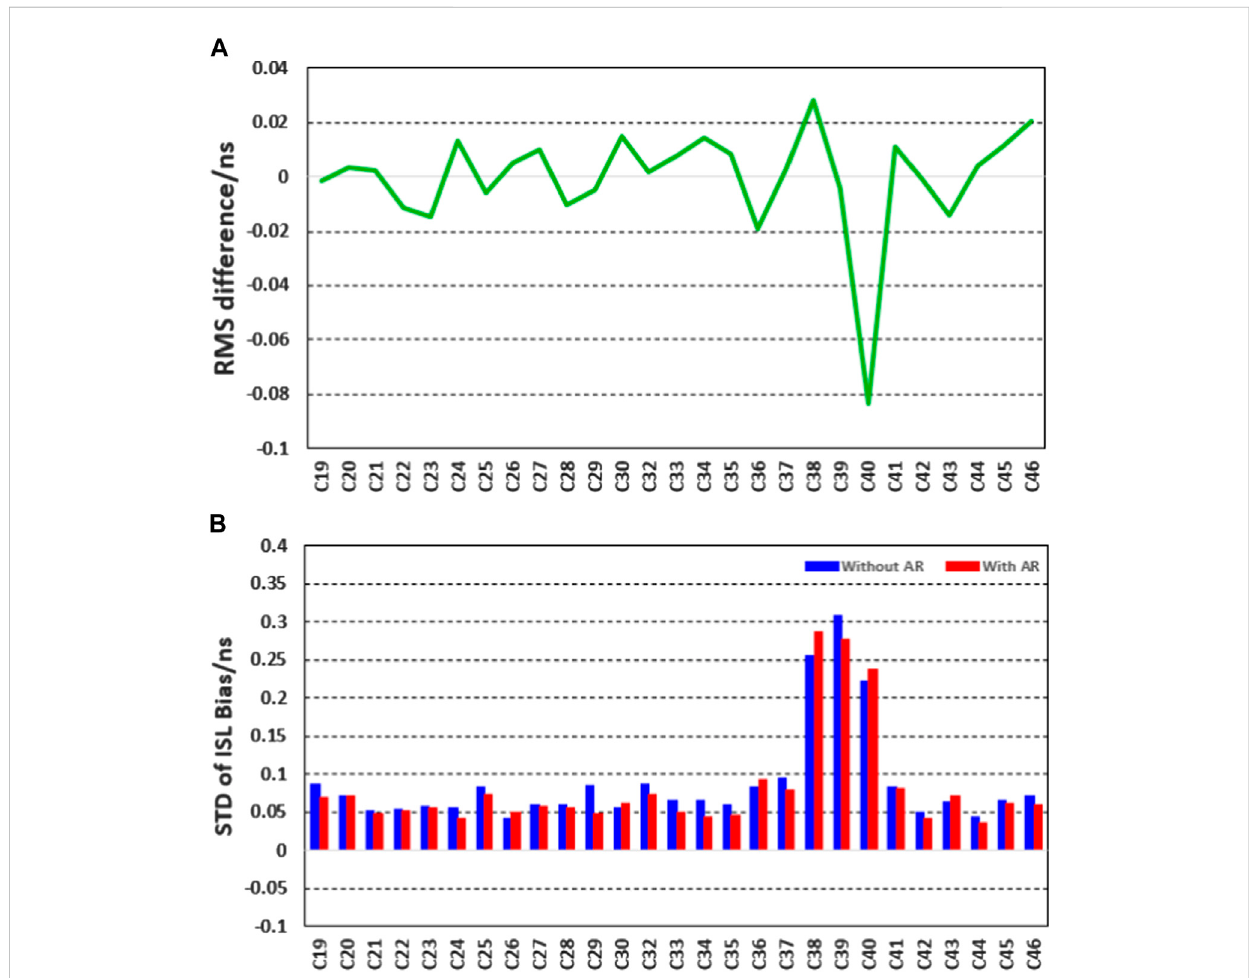
FIGURE 7 StatisticalRMS(theupperpanel) andSTDvalues(the bottompanel) ofISLhardwaredelaywithoutambiguityresolution forallBDS-3satellites. In (A) , the green curve denotes the RMS without ambiguity resolution minus the one with ambiguity resolution; in (B) , the blue bars represent the STD without ambiguity while red bars for the one with ambiguity resolution.